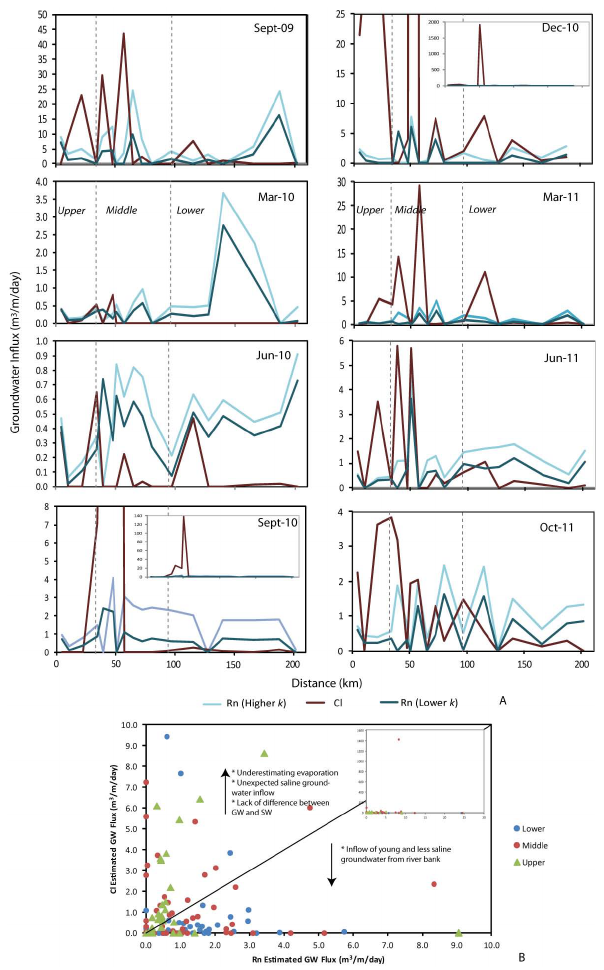
Fig. 9. (A) Comparison of baseflow fluxes in each sampling round, estimated from 222 Rn activities and Cl concentrations using Eqs. (1) and (4), respectively. For Rn, baseflow fluxes based on higher and lower k values are shown. (B) A scatter plot of all 222 Rn- and Cl- derived groundwater influxes (for Rn only those based on higher k values are shown in the graph). If the 222 Rn and Cl derived groundwater influxes agree to each other, they should be plotted in a straight line. Data points above the line indicate that Cl-derived groundwater inflows exceed 222 Rn-derived groundwater inflows, and vice versa. The possible reasons for the discrepancies are given in the graph. Both (A) and (B) shows Cl concentrations generally yield higher baseflow fluxes in the upper catchment but lower base- flow fluxes in the lower